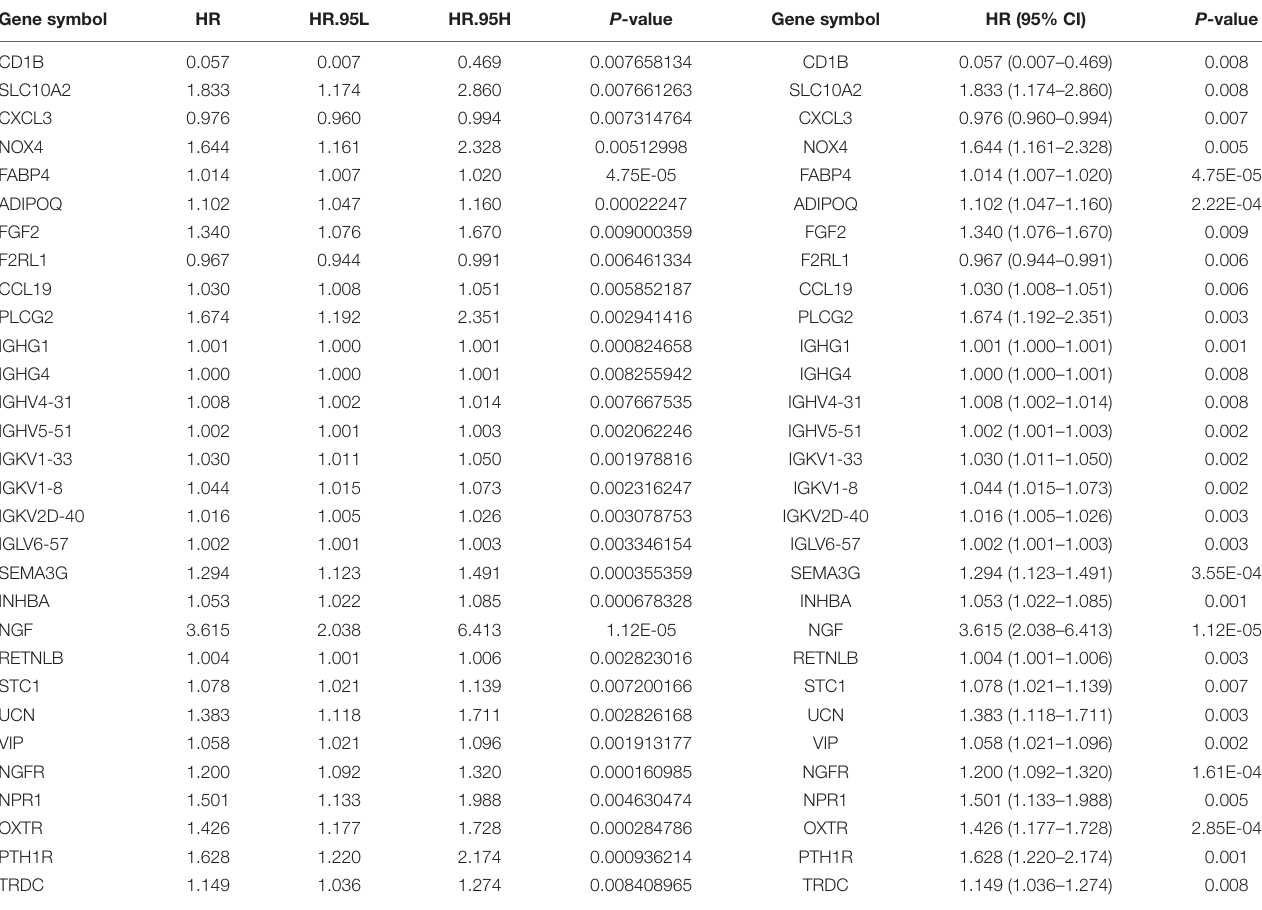
TABLE 1 | General characteristics of prognostic immune-related